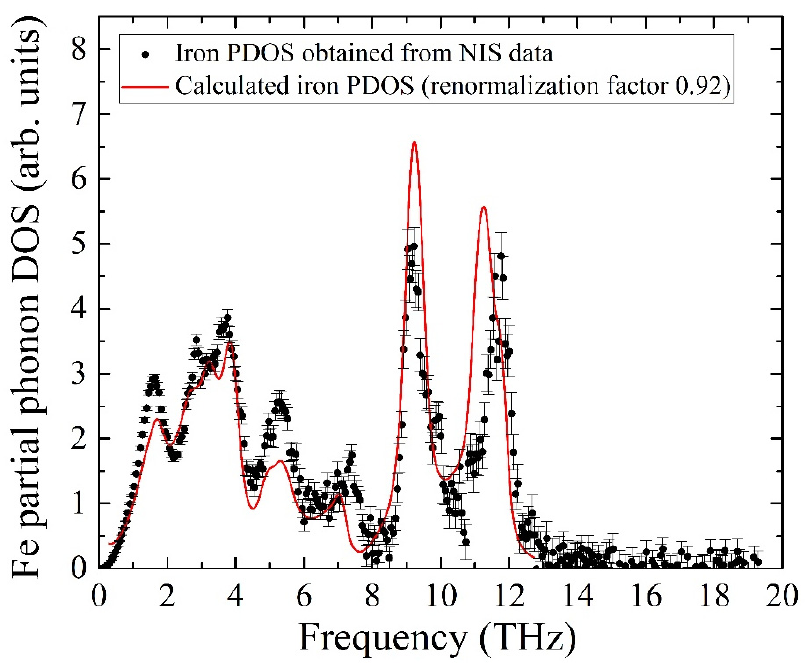
Figure 7. Partial PDOS for iron atoms of KFeS 2 obtained from the NIS spectrum (black dots) and from ab initio calculations (red line, see description in the body text).